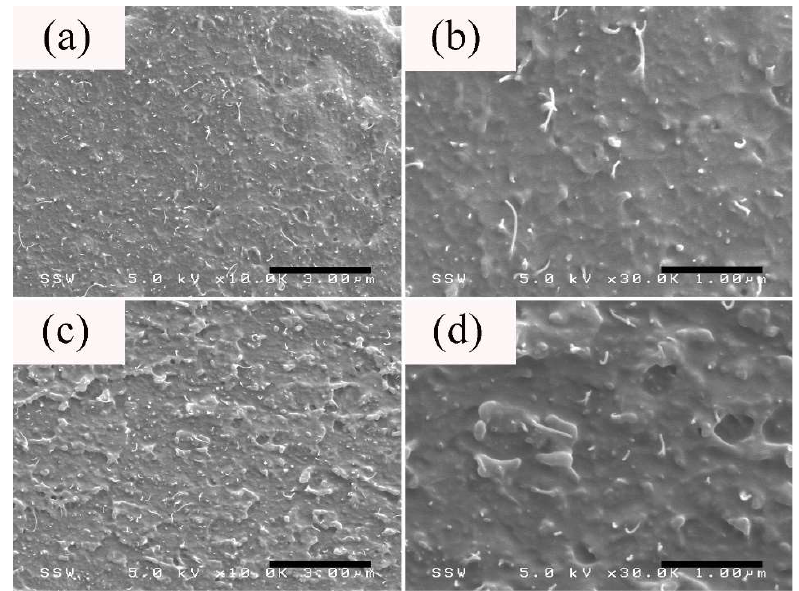
Figure 6. The morphology (TD) taken from the ( a , b ) core and ( c , d ) shear layers of the thick section of PS/CNT 5 wt % microparts.